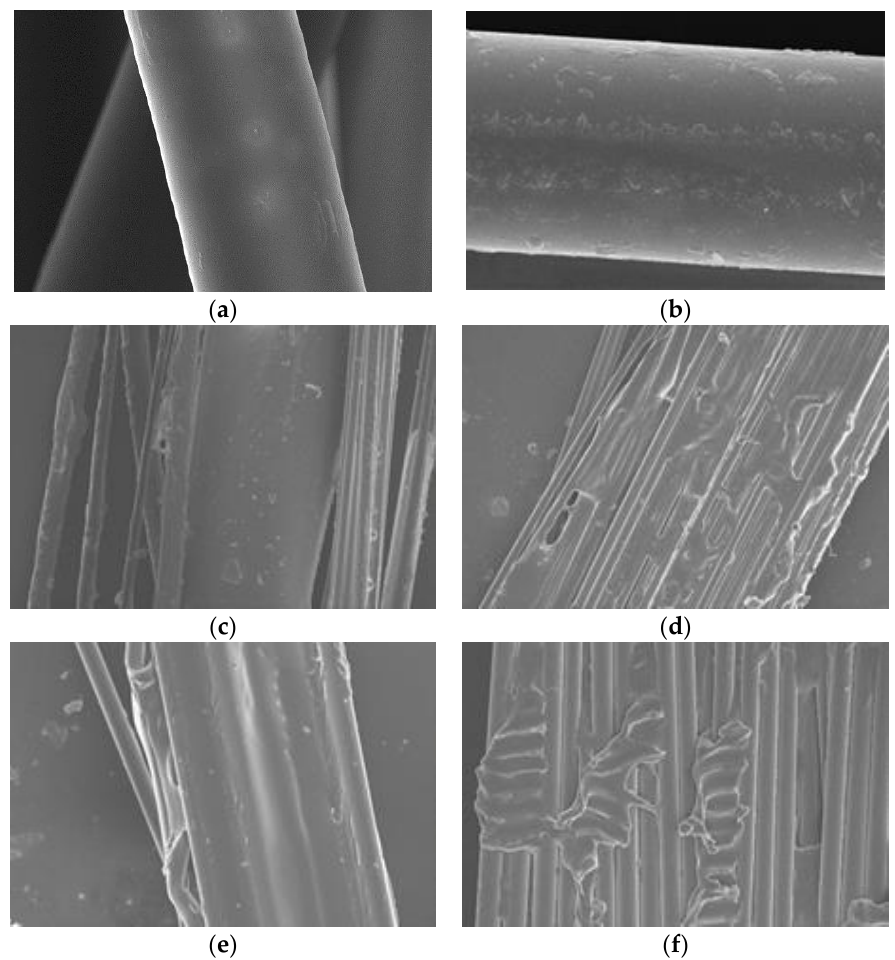
Figure 2. SEM images of basalt fibres: ( a ) un-sized (Basalt 1), and ( b ) plasma-treated (Basalt 11); ( c )